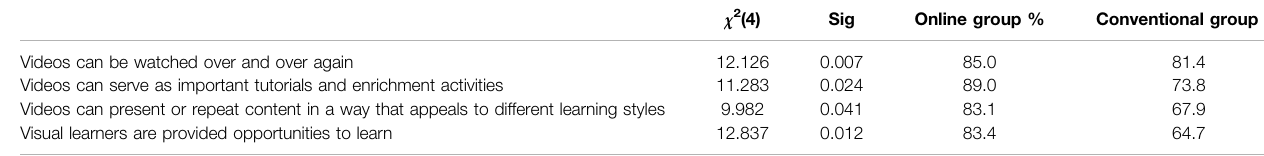
TABLE 4 | Results of chi-square analysis, and percentage of instructors in the Online Group and Conventional Group always or very often employing the following tools.